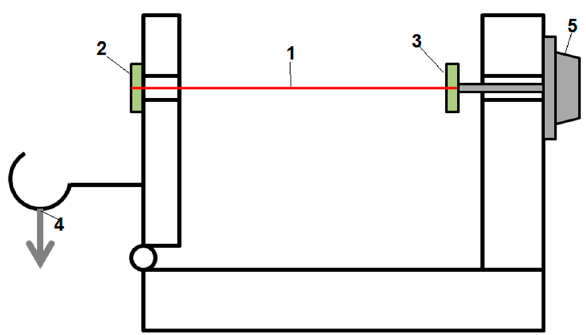
Figure 2. Schematic of the mounting of the wire sample. 1—amorphous wire, 2—fixed electrode, 3—rotating arm with electrode, 4—applied load, 5—precise rotation knob.